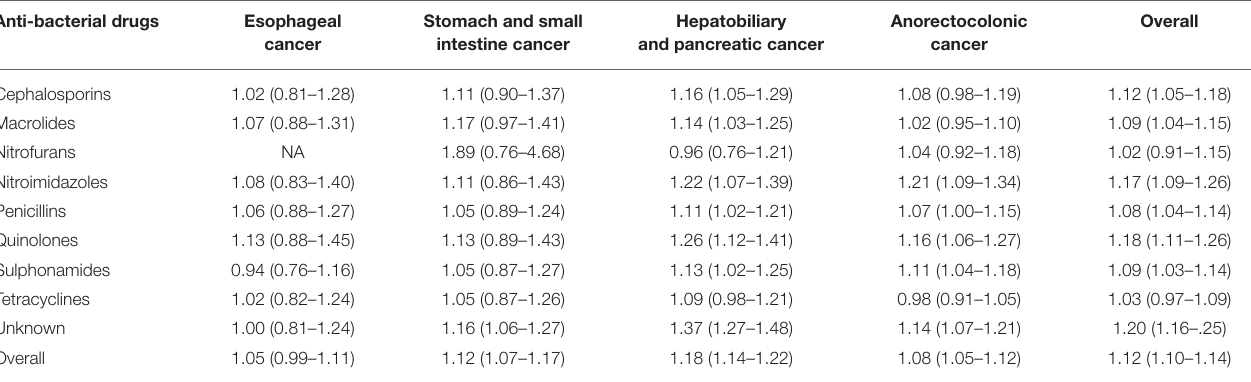
TABLE 2 | Risk assessment of each anti-bacterial drug class and digestive cancer